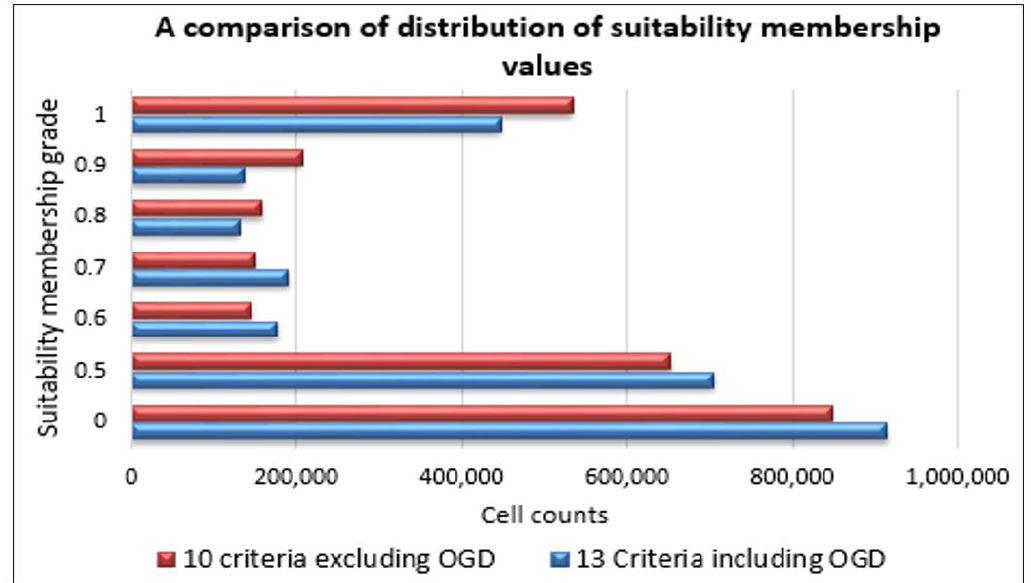
Figure 9. Comparison between landfill suitability maps with and without OGD